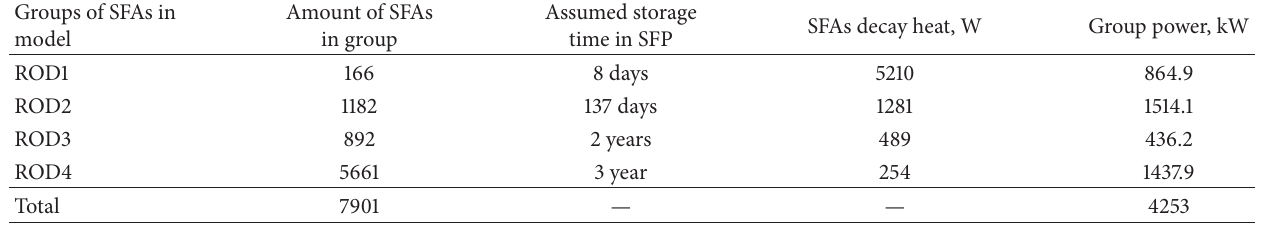
Table 1: Parameters of SFA in SFP.